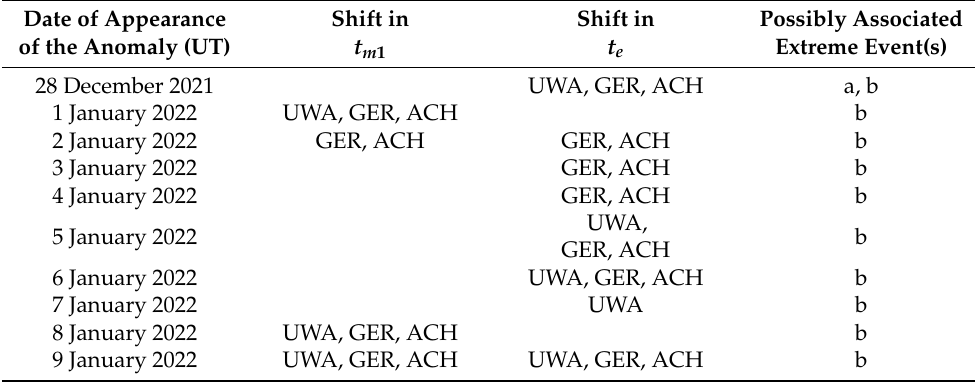
Table 4. Results from the diurnal sequential plots for the 2022 Cyprus EQ. UWA, GER, and ACH denote the station where the corresponding anomaly in t m 1 and/or t e has been identified.